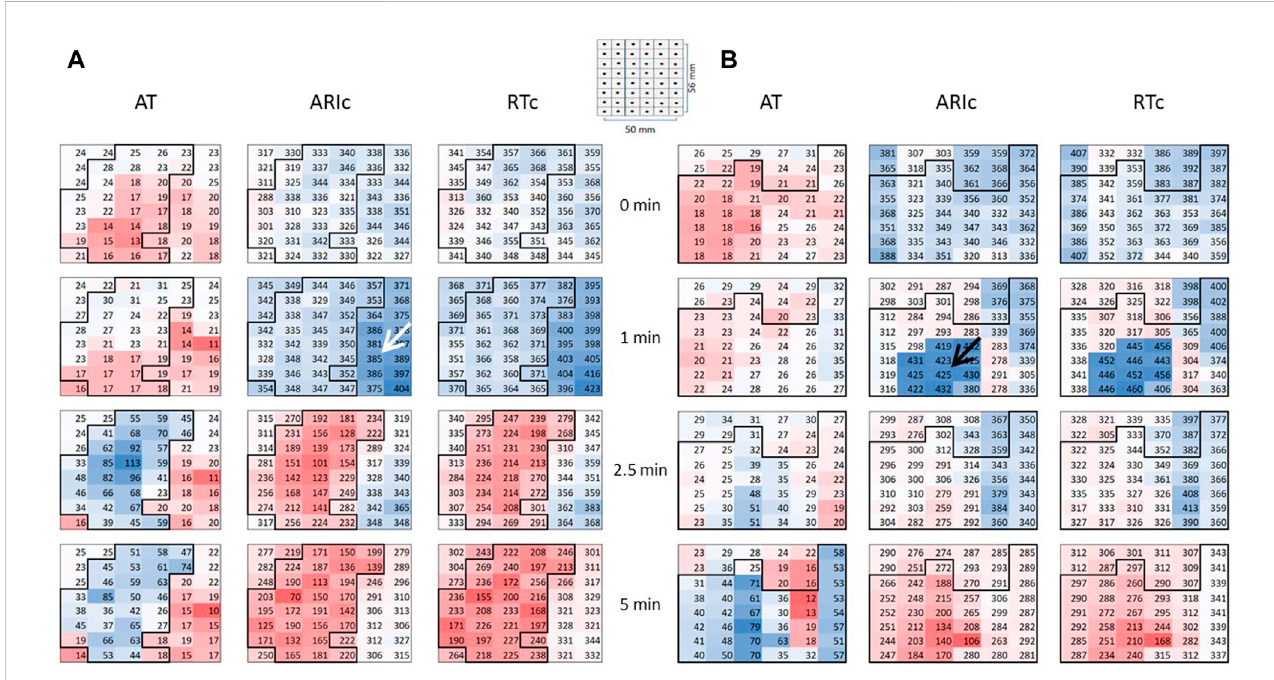
FIGURE 2 Representative epicardial maps of ATs, ARIc, and RTc in the affected area in two pigs (A,B) . Numbers and color labeling (red for short and blue for long) indicate AT, ARIc, and RTc values in the individual leads. RTc values were calculated as RTc = AT + ARIc. See the resemblance of ARIc and RTc maps. Color labeling isthesamethroughoutall time-points ineachofsixsetsofmaps(verticalcolumns).ThecoreischemiczonewasdeterminedonthebasisofATmaps (left columns in panels A and B ). To do it, AT values were compared between baseline (0 min) and ischemia (1, 2.5, 5 min). The area with the ischemia- related delays of AT at 1, 2.5, or 5 min is outlined with bold contours and referred to as a core ischemic zones. The surrounding area is identi fi ed as a border ischemic zone. Pigs (A,B) demonstrated ARIc prolongation in the border (white arrow) and core (black arrows) ischemic zones, respectively. Spatial parameters of the maps are presented in a